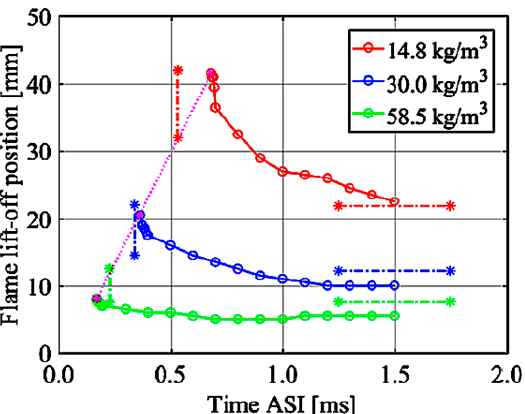
Figure 34. Ambient pressure effect on flame lift-off positions of the reacting sprays as a function of time after start of injection (ASI). Basic conditions are same as Case 4 in Table 6. Vertical and horizontal dash-dotted lines with asterisks represent the experimental ignition delay times and averaged flame lift-off lengths, respectively. Magenta dotted line indicates the boundary separating the domains of ignition (latter time domain after ignition) and the domain of induction to ignition (former time domain before ignition) [39].